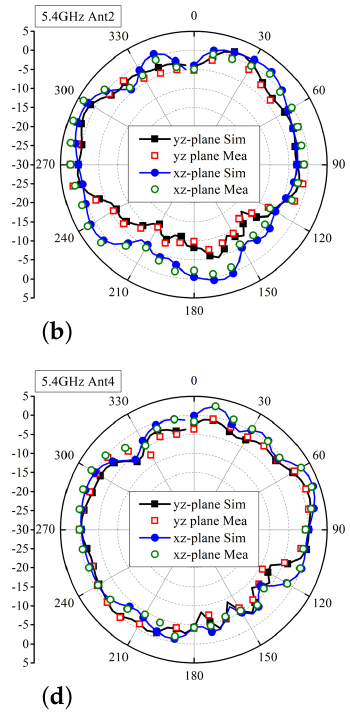
Figure 10. Radiation characteristics of the proposed antenna at 5.4 GHz for ( a ) Ant 1, ( b ) Ant 2, ( c ) Ant 3, and ( d ) Ant